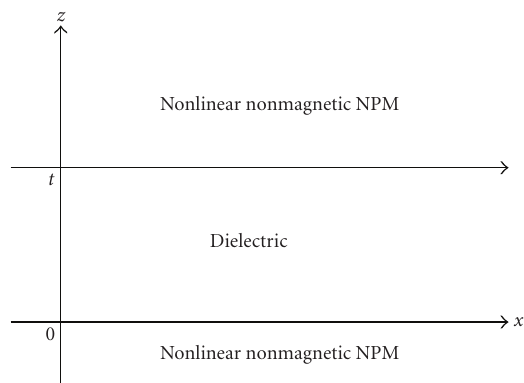
Figure 1: symmetric waveguide structure; linear dielectric medium nonlinear-bounded by nonlinear nonmagnetic NPM